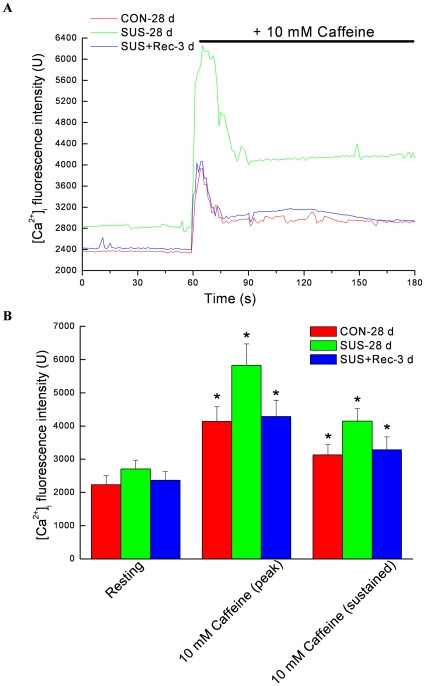
Caffeine elicits the increases of intracellular Ca2+ fluorescence intensity in cerebral VSMCs isolated from CON-28 d, SUS-28 d, and SUS+Rec-3 d rats.(A) Representative dot graph of Fluo-3/AM fluorescence recorded showed the typical transient increases of intracellular Ca2+ fluorescence intensity evoked by 10 mM caffeine. Caffeine was present at times shown by the horizontal bar. (B) Summarized data indicated the average changes of the intracellular Ca2+ fluorescence intensity before and during the application of caffeine. Values are means ± SE with the number of cells recorded in parentheses. CON-28 d: 28-day simultaneous control rats, SUS-28 d: 28-day tail-suspended rats, SUS+Rec-3 d: tail-suspended rats submitted to a recovery period of 3 days at the end of 28-day suspension. *P<0.05 as compared with their controls by t-test, respectively.